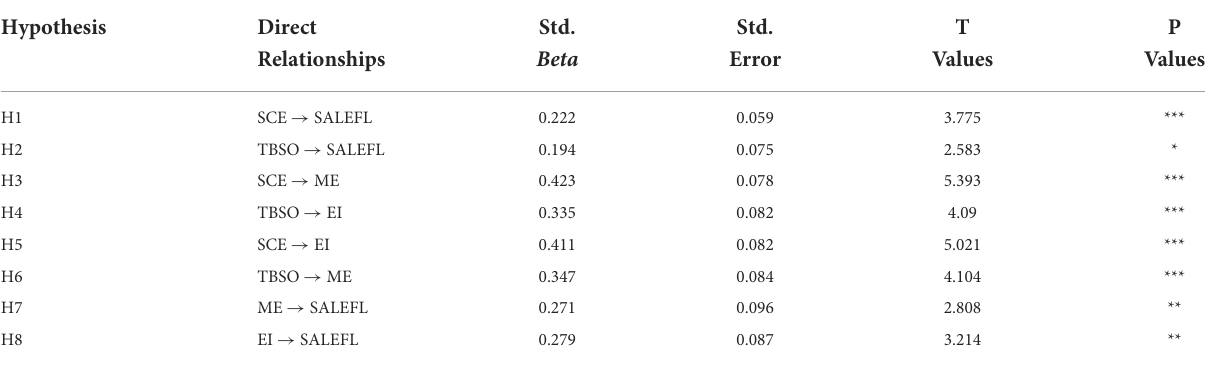
FIGURE2 Assessment of measurement model.